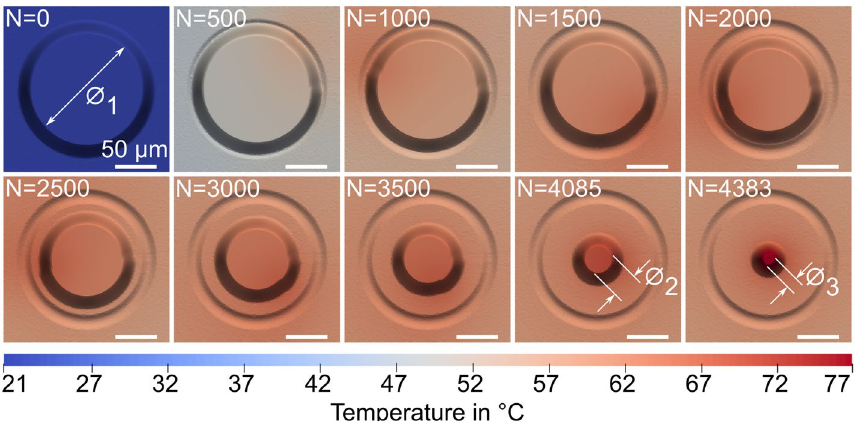
Figure 4. Plan view of the pre-pillar isolation. N is the pulse number in the scanning pattern. N = 0, ∅ 1 = 131.94 µ m is the initial surface diameter at the start of the 150–50 µ m inbound anticlockwise hatch pattern. N = 4085, ∅ 2 = 31.94 µ m is the final pre-pillar that Groetsch et al. 33 produced. N = 4383, ∅ 3 = 11.94 µ m is a theoretical pillar produced with consistent scanning parameters down to a diameter of 30 µ m